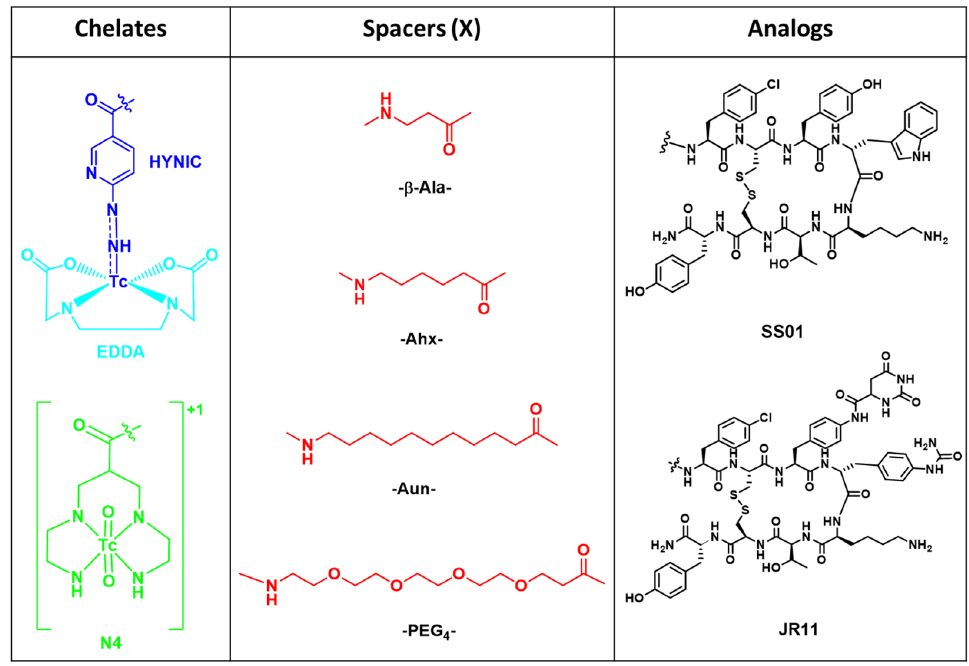
Figure 1. Chemical structure of the SST2 analogs SS01 and JR11, the 99m Tc-chelates and the spacers (X).